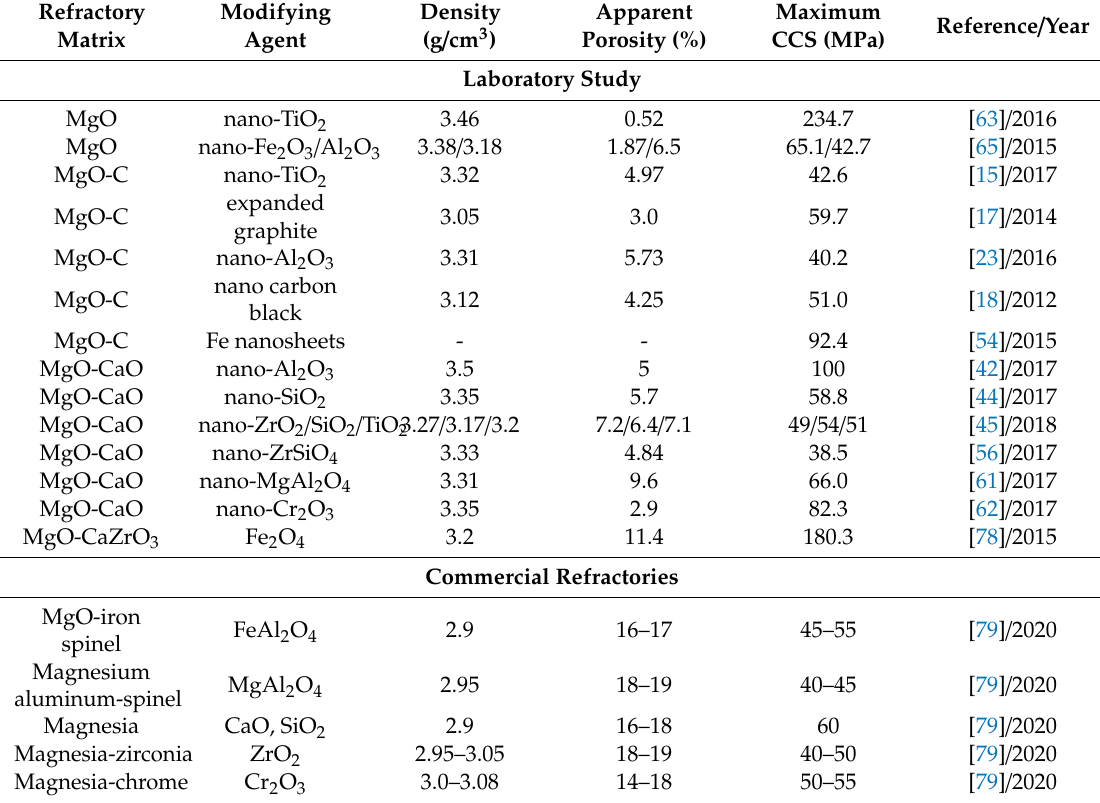
Table 5. Physical and mechanical properties of MgO-based refractories from laboratory studies and commercial